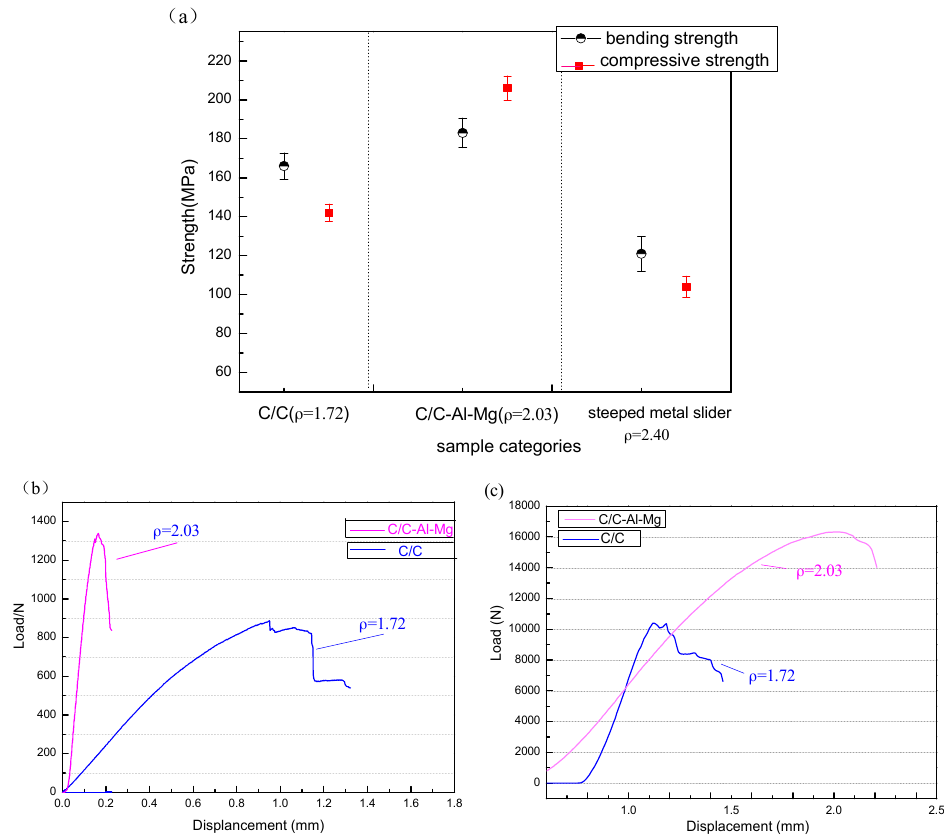
Figure 6. Mechanical properties and force–displacement curve of the composites. ( a ) The bending and compressive strength of the composite; ( b ) The force–displacement curve (bending property); ( c ) The force–displacement curve (compressive property).